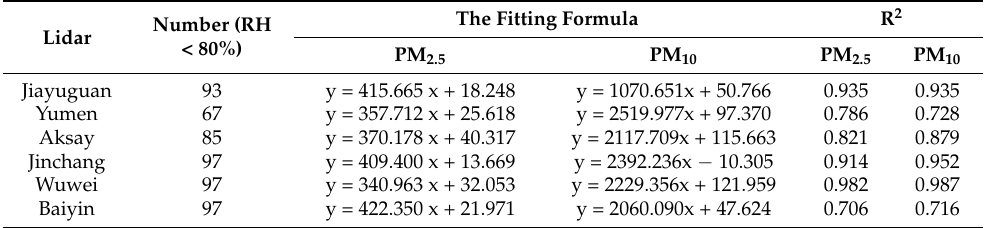
Table 3. The fitting formula between PM 2.5 , PM 10 concentration from ground observation and extinction coefficient (y = ax + b) of 532 nm at 150